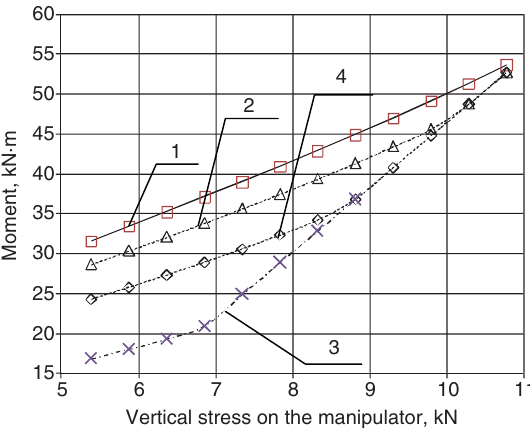
Fig. 3. Changes of hinge workload by means of the torsional moment under different stiffness of the block system: 1 – C (cid:1) 2.0·10 6 N·m/rad; 2 – C (cid:1) 1.5·10 6 N·m/rad; 3 – C (cid:1) 5.0·10 5 N·m/rad; 4 – C (cid:1) 1.0·10 6